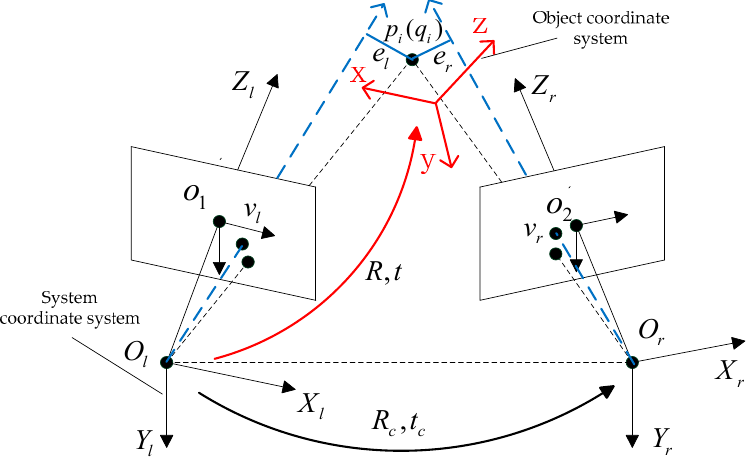
Figure 2. of the extended binocular orthogonal iterative algorithm.